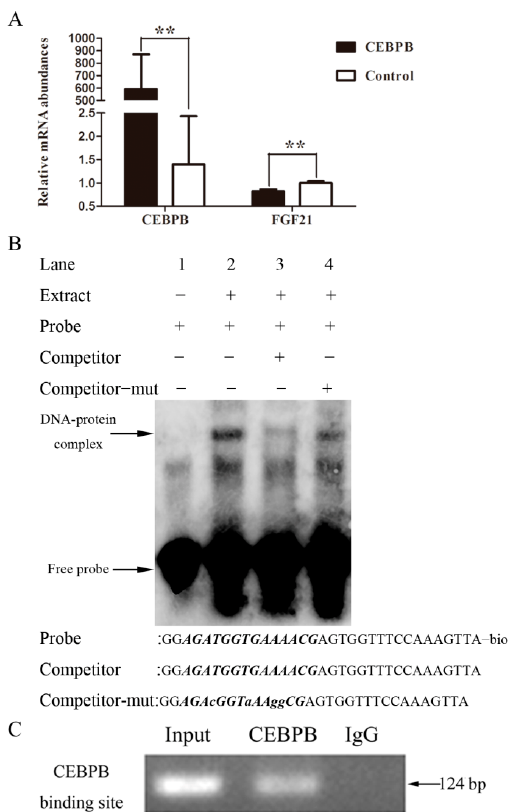
Figure 7. The transcription factor CEBPB suppressed FGF21 expression by binding to FGF21 promoter. QRT-PCR analysis showed CEBPB reduced FGF21 mRNA level. ** for 0.001 < p < 0.01 ( A